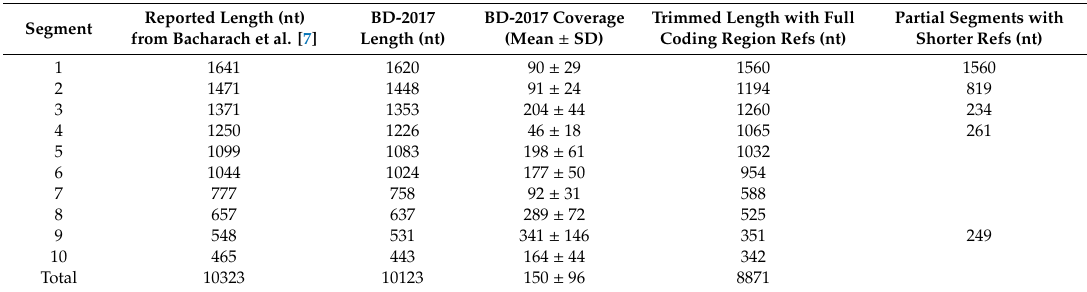
Table 1. Length and coverage of the Tilapia lake virus (TiLV) segments from the Bangladesh isolate, and length of sequences used for phylogenetic analyses.